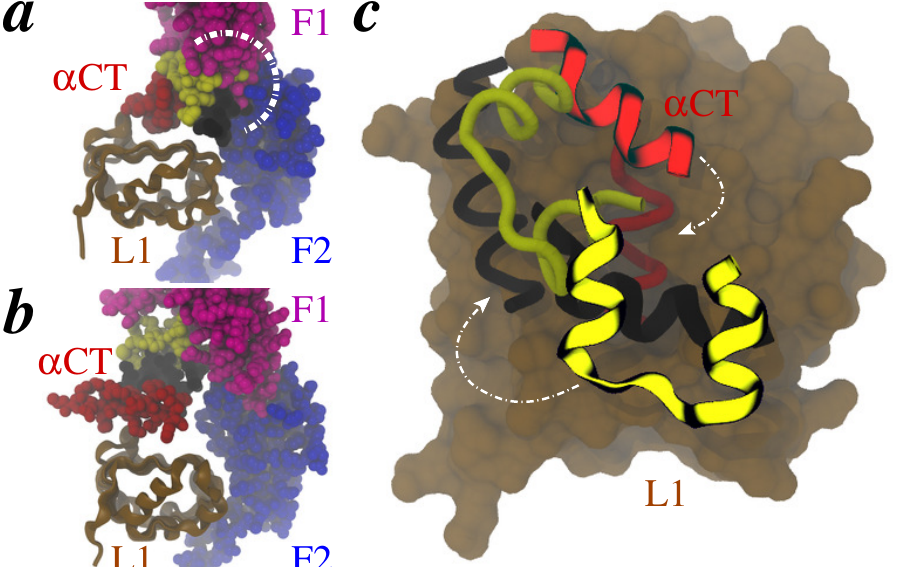
Figure 3. Insulin/IR complexes. ( a ) Alignment of insulin-bound structure of IR fragment (PDB code 3W11) with the apo-IR ectodomain (PDB code 3LOH). Insulin chains (A-chain, yellow; B-chain, black) and the F1 (magenta) and F2 (blue) domains of IR are rendered as space-filling, while the L1 domain (brown) is shown in a cartoon representation. Area of overlap between insulin residues and the F1/F2 loops is marked by a white arc. ( b ) Same view as in a from an all-atom structural model of insulin bound to IR ectodomain by Vashisth and Abrams [61]. Some residues of insulin are hidden behind the F1 and F2 domains. ( c ) Overlay of insulin/ α CT on the L1 surface (brown) from the insulin-bound crystal structure (tubes) shown in a , and from the predicted model (cartoons) shown in b . White arrows indicate possible rotation of insulin/ α CT (on the L1 surface) required to achieve crystal conformations starting with the predicted model